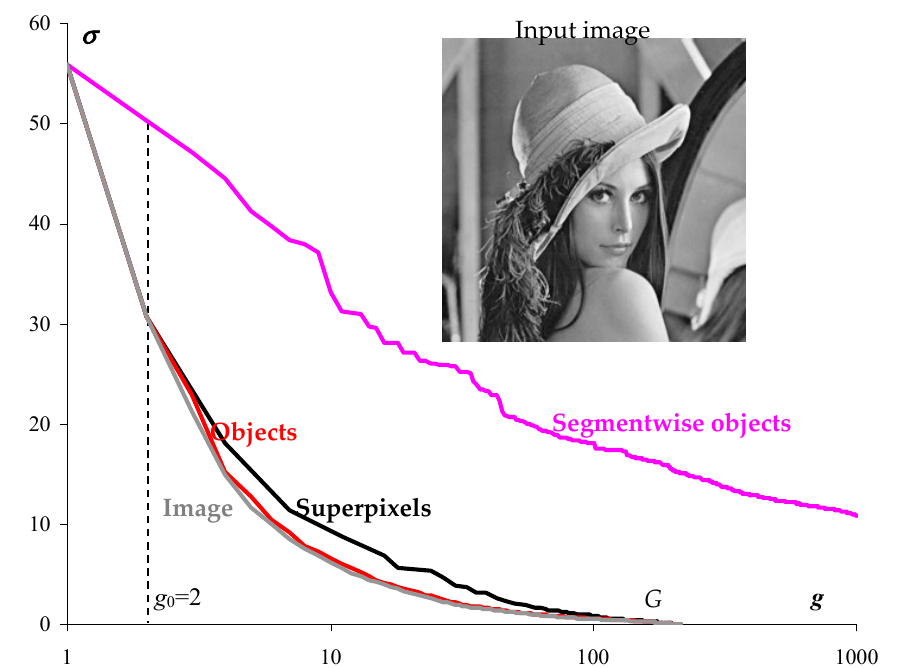
Figure 2. Structural representations of image, objects, and superpixels. The plots illustrate the standard deviation σ of approximations from the image depending on cluster number g . The upper purple curve describes the hierarchical segmentation of the image. The black solid curve describes the superpixel hierarchy. The lower gray curve describes the sequence of optimal image approximations, and the red curve describes the object binary hierarchy of approximations obtained by the hierarchical Otsu method [9,10,26].